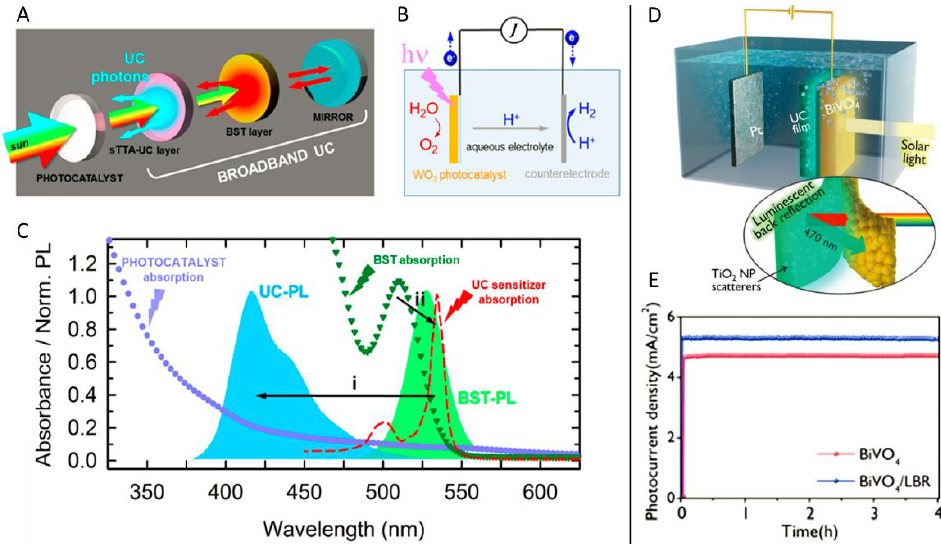
Figure 12. ( A ) Schematic diagrams of the multilayer broadband upconversion in ( B ) a classical photoelectrochemical water splitting cell with WO 3 , PtOET, DPA, poly(lauryl methacrylate) doped with CdSe/ZnS nanocrystals, and aluminum as photocatalyst, sensitizer, emitter, boosting layer (BST), and black mirror, respectively. ( C ) Absorption and fluorescence spectra of different layers. Reprinted with permission from ref. [135]. Copyright 2017 American Chemical Society. ( D ) Schematic diagram of the LBR-assisted photoelectrochemical water splitting of Mo:BiVO 4 photocatalyst and ( E ) photocurrent-time responsive curves of Mo:BiVO 4 photoanodes with and without the LBR layer. Reprinted with permission from ref. [136]. Copyright 2019 Wiley Online Library.